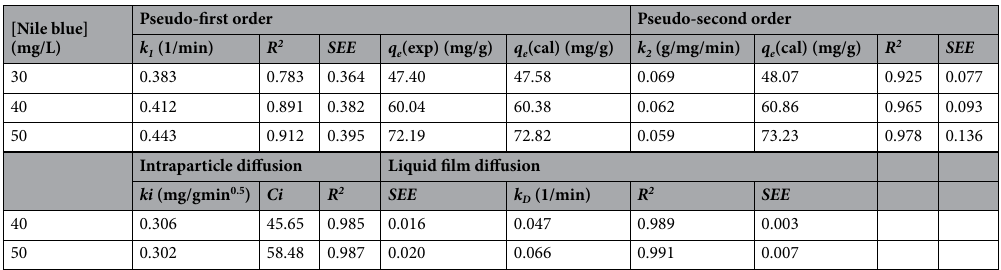
Table 4. Kinetic and diffusion